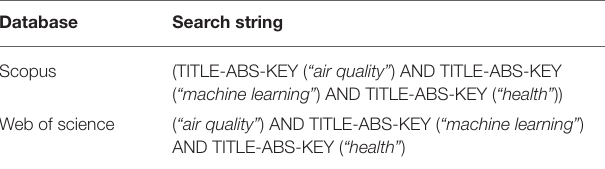
TABLE 1 | Search string of databases (Scopus and Web of Science). TABLE 2 | Inclusion and exclusion criteria for the searching in